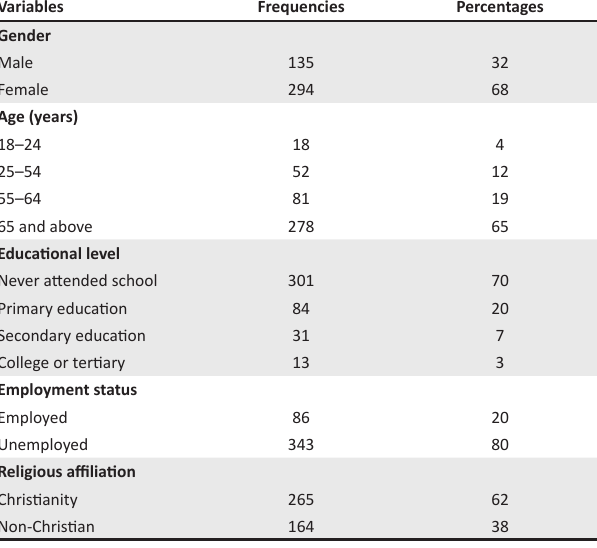
TABLE 1: Socio-demographic characteristics of the study participants. Variables